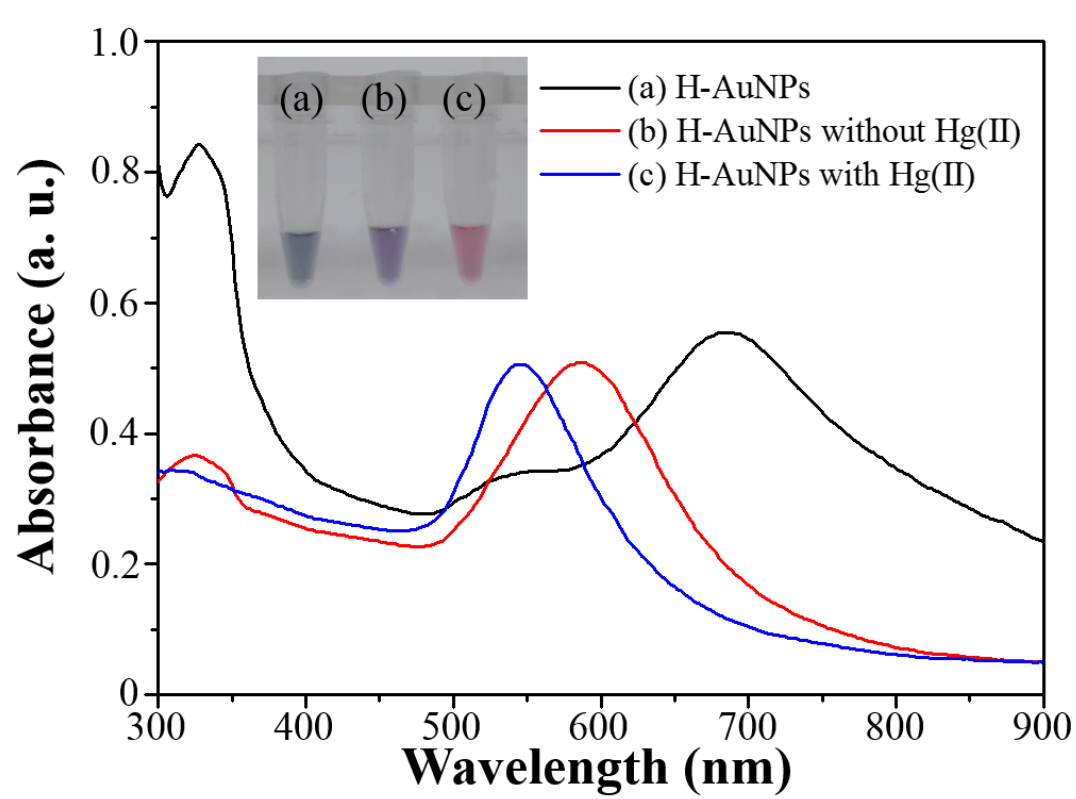
Figure 1. UV-Vis spectra of ( a ) the H-AuNS probe prior to the reactions and the H-AuNS probe, ( b ) without and ( c ) with Hg(II) (1.0 µM) in the presence of the HCl/Au(III)/H 2 O 2 solution. Inset: color visualization for (a), (b) and (c).